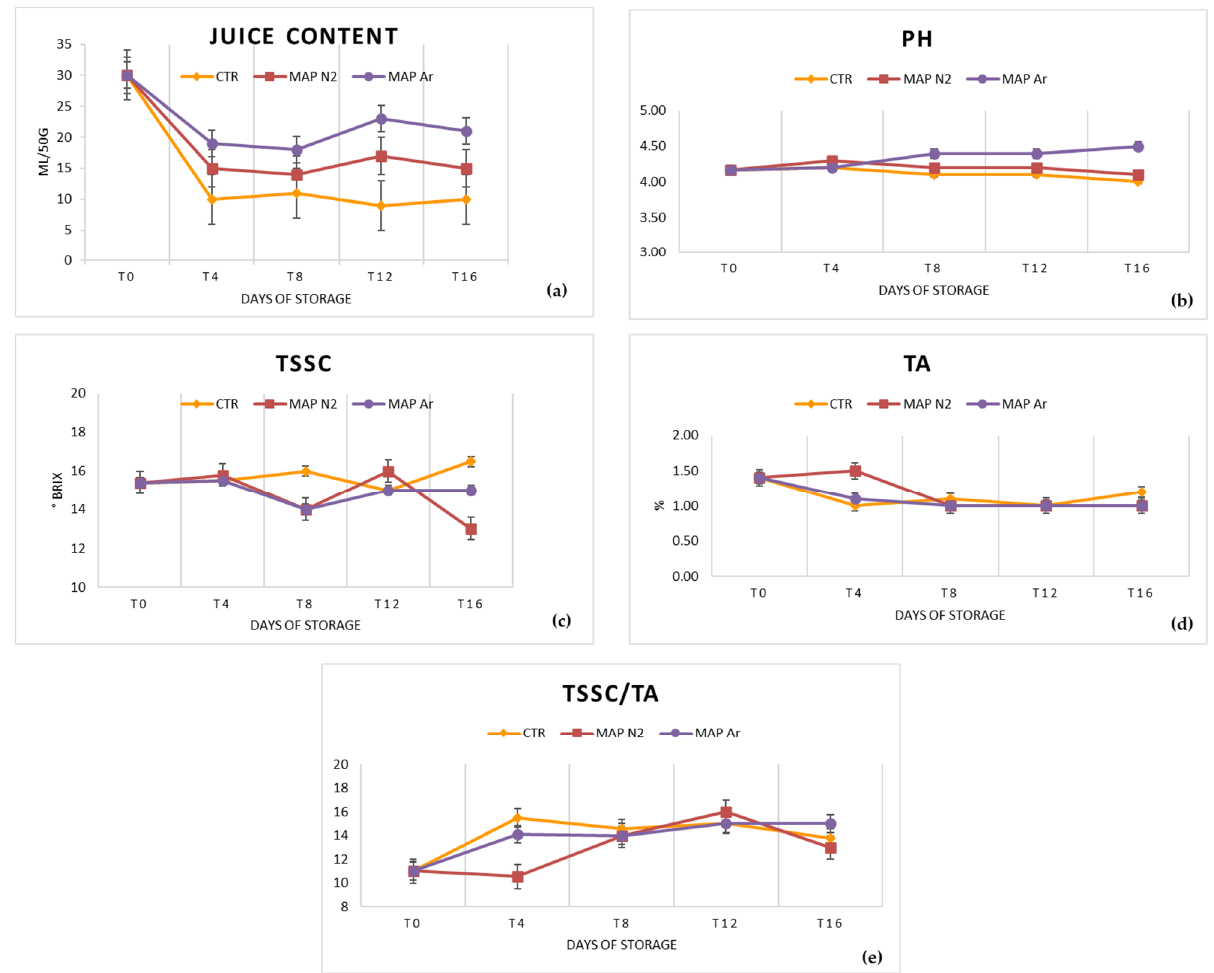
Figure 3. Results of the analyses of ( a ) juice content (mL/50 g); ( b ) pH; ( c ) TSSC (total soluble solids content, °Brix); ( d ) TA (titratable acidity, g L −1 citric acid); ( e ) TSSC/TA ratio treated with MAP (CTR: 20.9% O 2 + 0.04% CO 2 (passive-MAP); MAPN 2 : 10% O 2 + 5% CO 2 + 85% N 2 ; MAPAr: 10% O 2 + 5% CO 2 + 85% Ar). Values were recorded at 0 (T 0 ), 4 (T 4 ), 8 (T 8 ), 12 (T 12 ), and 16 (T 16 ) days at 4 ± 1 °C and 90 ± 5% RH. Values represented as mean ± SD.